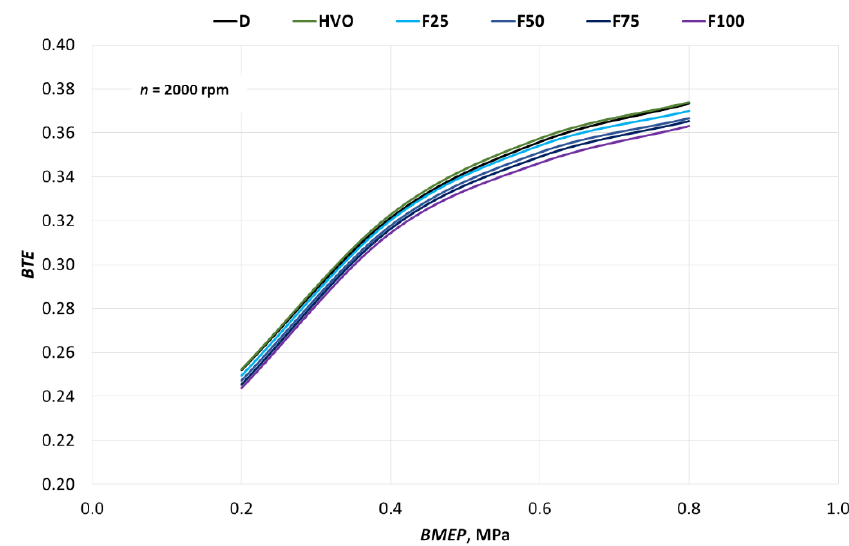
Figure 13. Dependence of BTE on the load using different fuels.